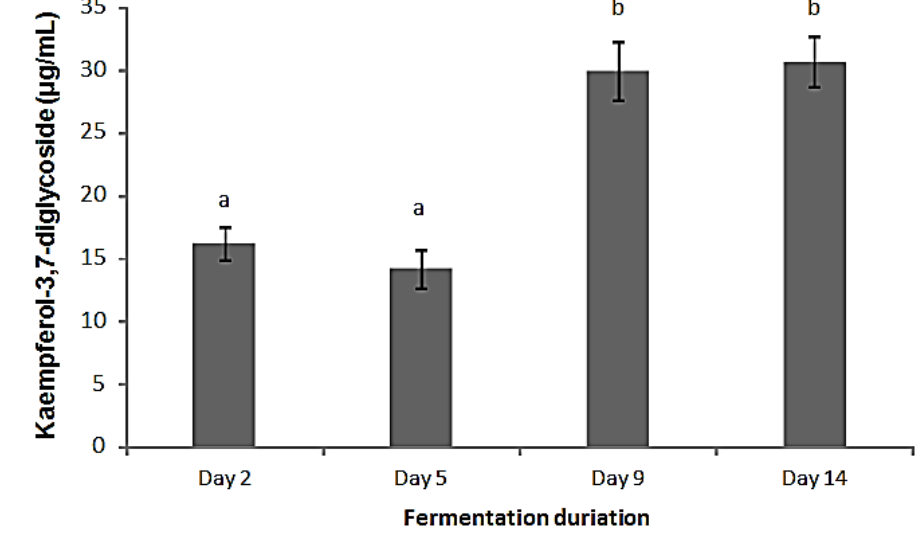
Figure 3. Changes in kaempferol-3,7-diglycoside levels in radish brines during fermentation. Results were expressed as µg kaempferol equivalents/mL. Tests were conducted in triplicate, with mean values shown and standard deviations depicted by the vertical bars. Columns marked with different letters are significantly different ( p <0.05).